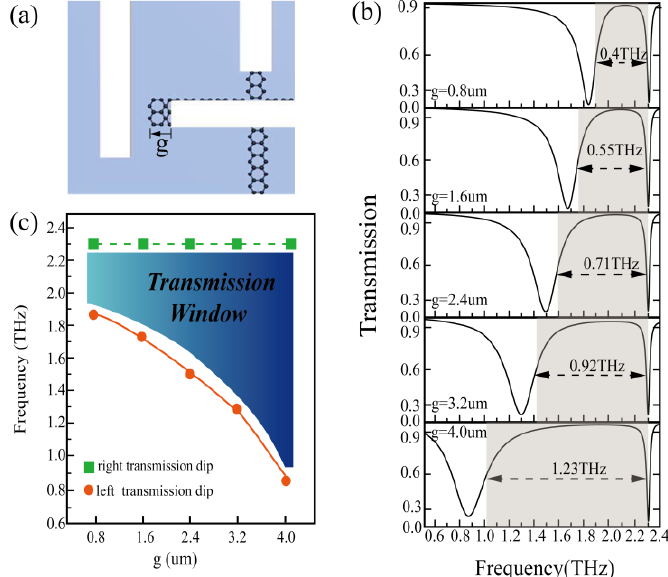
Figure 4. ( a ) Partial schematic of the proposed EIT-like metamaterial, ( b ) resonance frequency shift under different g , ( c ) transmission window under different g .